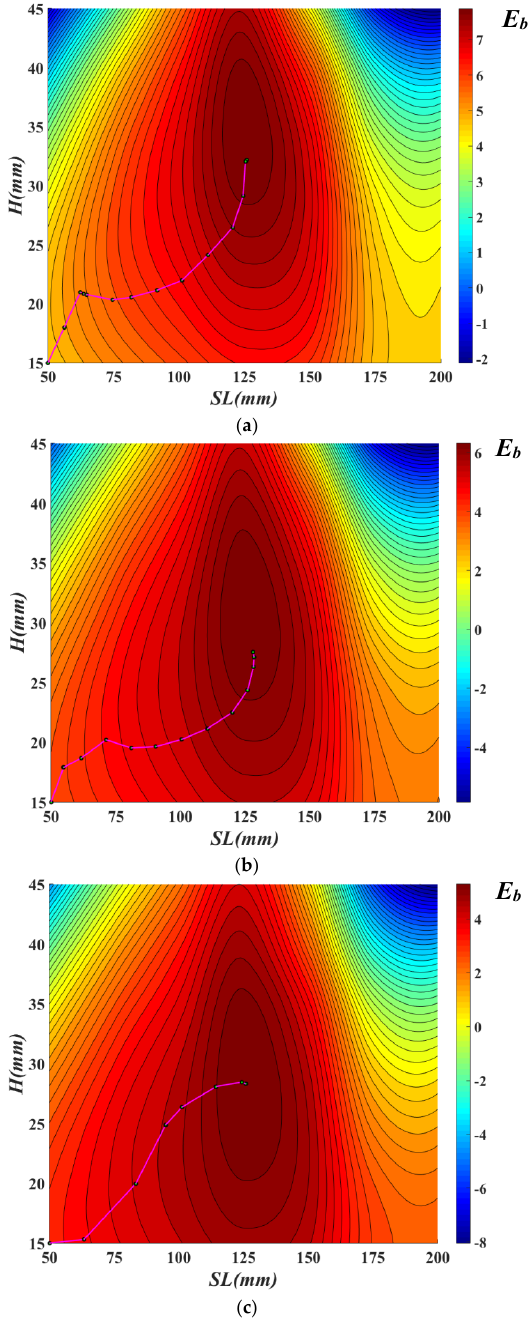
Figure 17. Iteration process to search for the optimum combination of pitch and height with V 0 = 16 kV at ∆ T = 33 K, 53 K and 73 K, respectively. ( a ) ∆ T = 33 K, V 0 = 16 KV; ( b ) ∆ T = 53 K, V 0 = 16 K; ( c ) ∆ T = 73 K, V 0 = 16